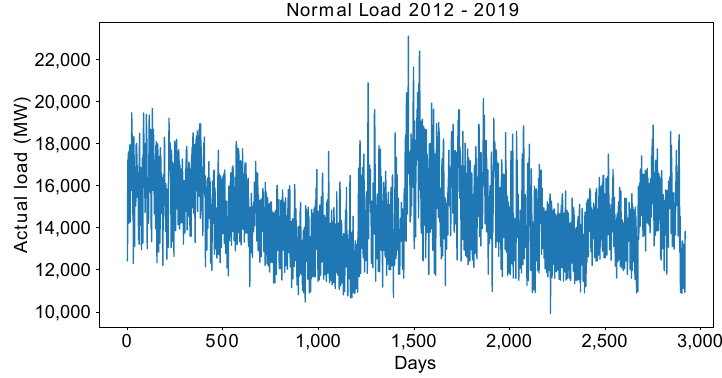
Figure 11. Normal electricity load.